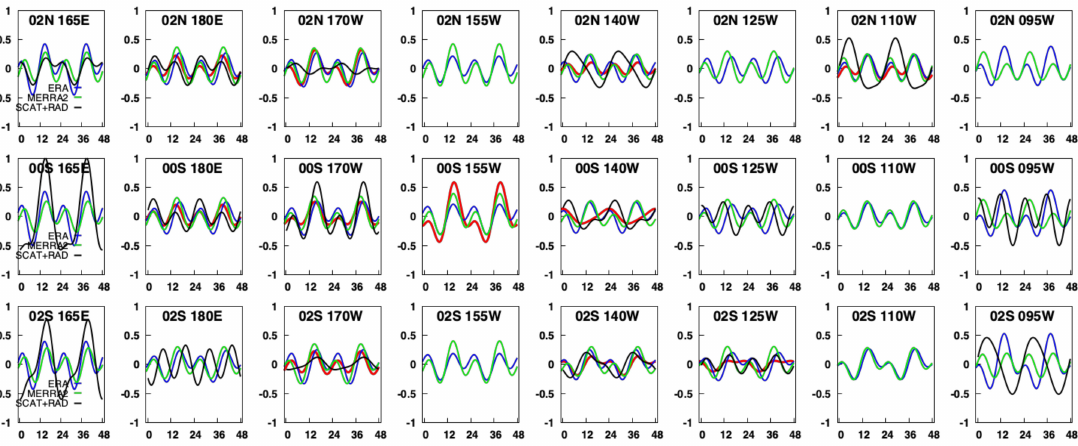
Figure 10. Same as Figure 8, but showing zonal ( u ) wind components from 2010, a year with moderate La Niña conditions. Positive (negative) values indicate westerly (easterly) winds relative to the daily mean. For many locations, TAO-TRITON and SCAT + RAD data are not shown owing to the limited number of observations.